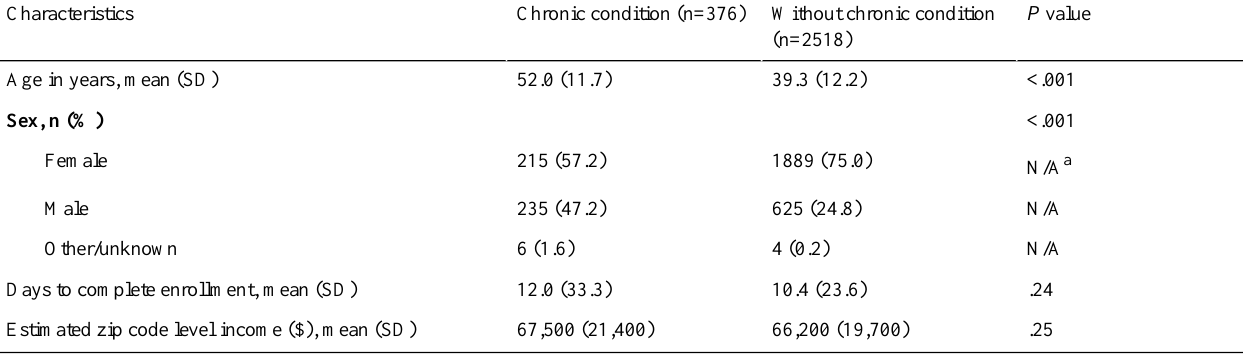
Table 1. Characteristics of participants with and without a chronic condition in the ImagineCare pilot.